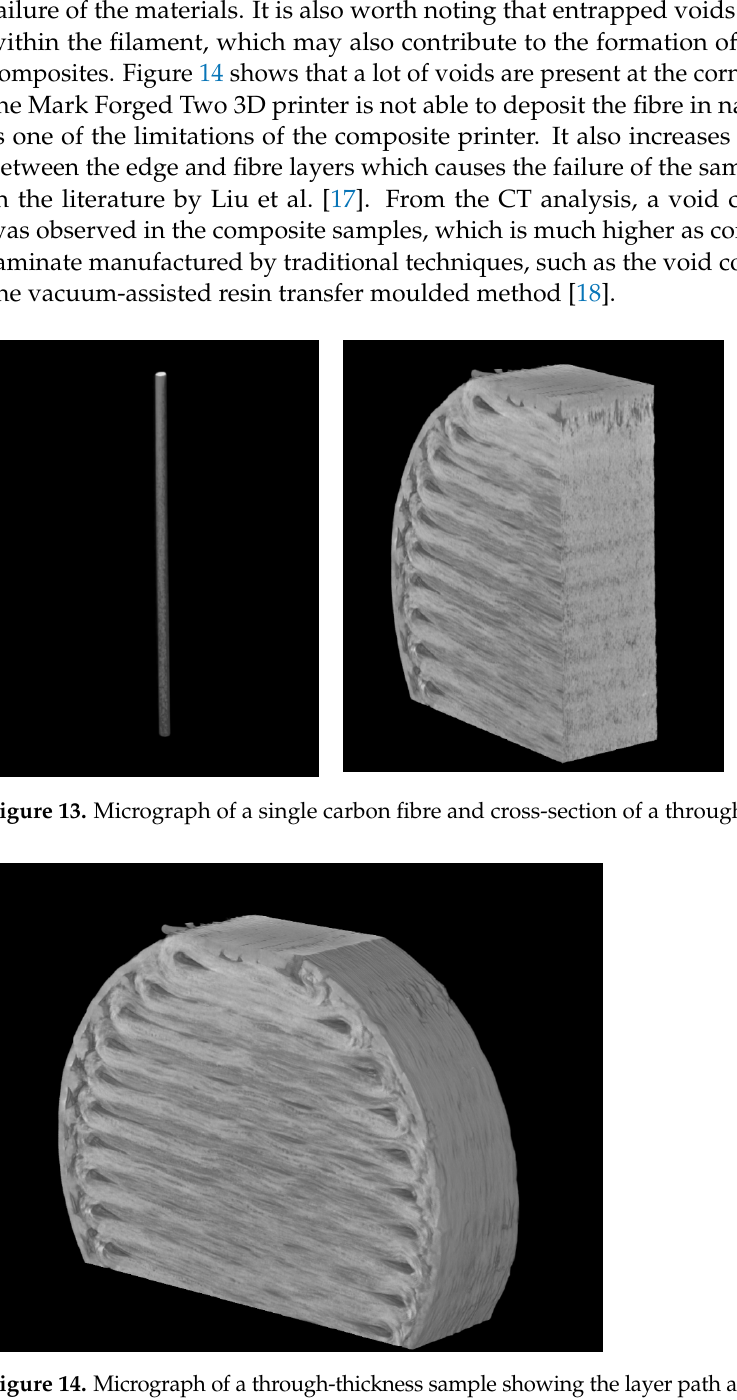
Figure 14. Micrograph of a through-thickness sample showing the layer path and the void distribu- tion.